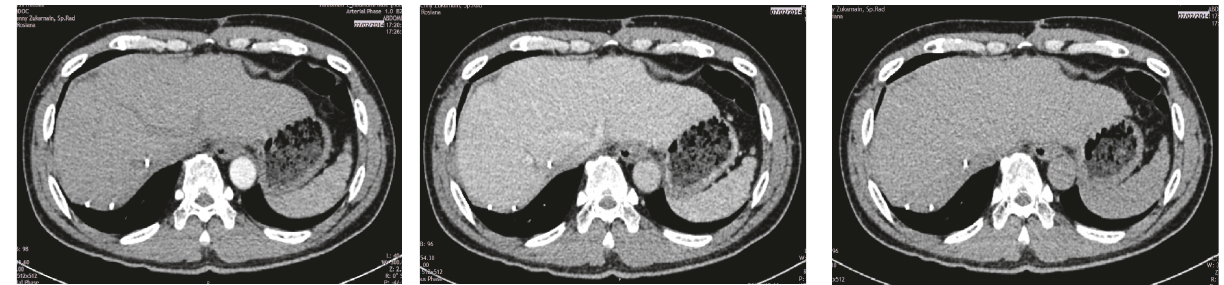
Figure 4: Arterial, venous, and delayed phase of Abdominal CT Scan 4 months after surgical resection (February 2014).